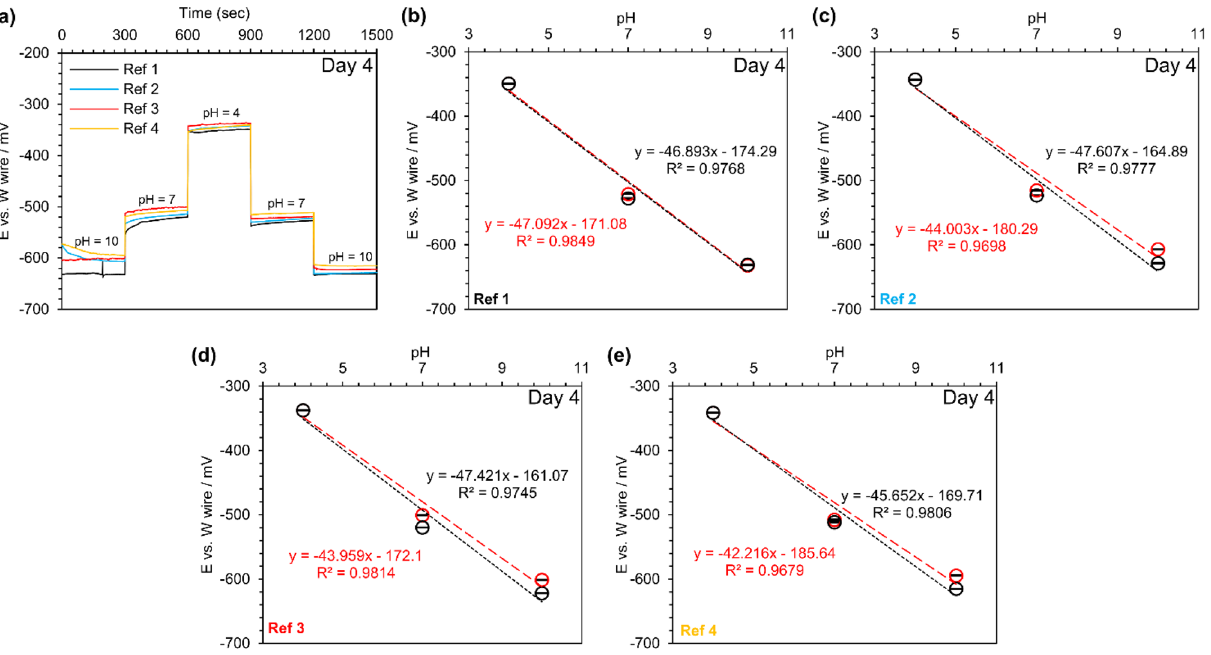
Figure 4. The long-term stability testing of tungsten wires with the custom-made reference electrodes at day 4: ( a ) real-time response of 5-min bleached silver wires versus a tungsten wire in standard buffers (pH 4, 7, and 10) after being stored in PBS for 4 days, ( b – e ) the calibration curves for each sensor. N = 4. Red colors show the decrease in pH, and the increase in pH is shown in black color.